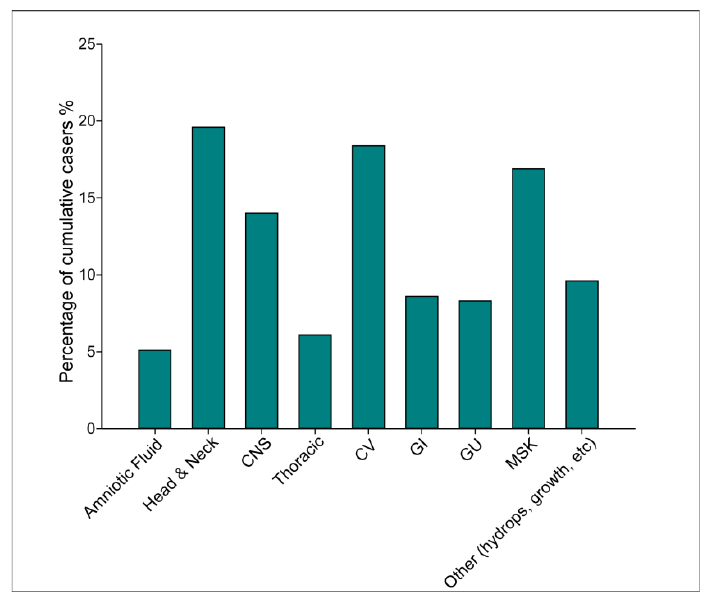
Figure 3. Cumulative distribution of fetal features in cases with positive NGS-based test results. A bar graph of the distribution of fetal features of cumulative cases who had prenatal and postnatal panel, and postnatal ES tests. Table 2. Prenatal whole exome sequencing cases.